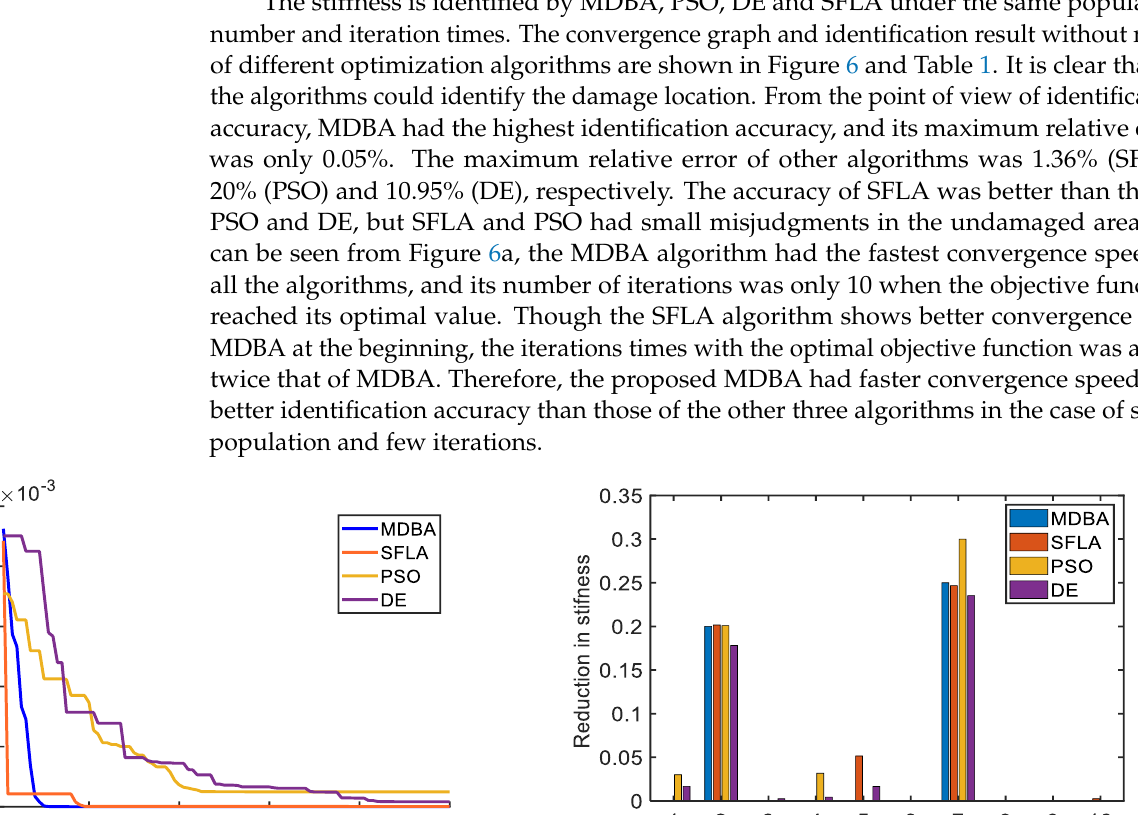
Figure 5. Case of damage beam-type bridge model.